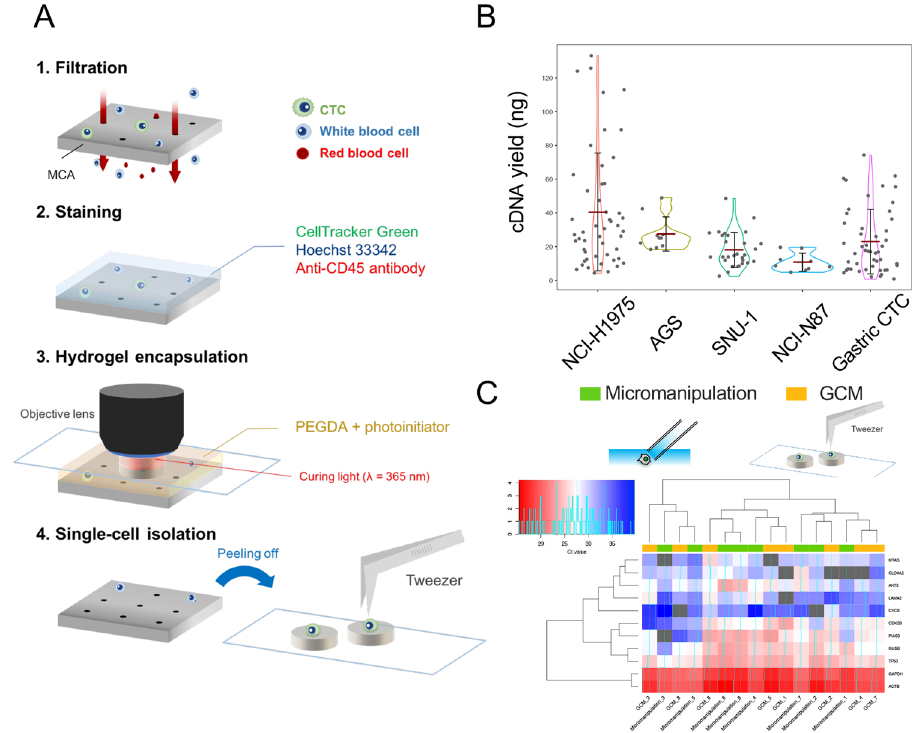
Fig. 1 Single-cell isolation and gene expression analysis based on microcavity array and gel-based cell manipulation. A Schematic overview of single- cell isolation based on MCA/GCM; B Violin plot shows the yield of WTA products from cancer cell lines and gastric CTCs. Each dot represents a single- cell. The red bar represents mean value. The black bar represents deviation. C Cluster analysis of single-cell gene expression patterns. Heat map shows Cq values of 11 genes by qPCR assays performed on single NCI-H1975 cells isolated by micromanipulation (green) and MCA/GCM (yellow). Red indicates high gene expression, white indicates median gene expression, blue indicates low gene expression, and gray represents undetectable